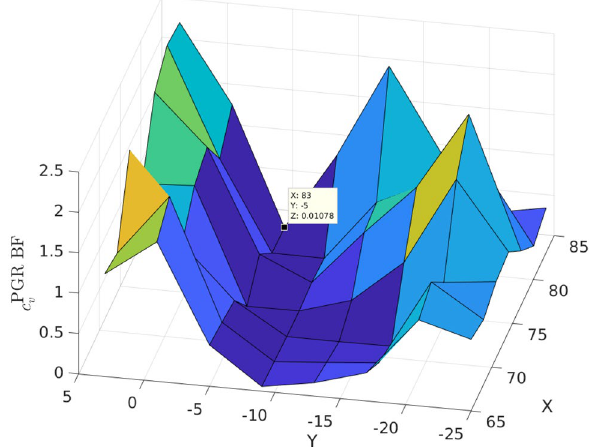
Fig. 21 c PGR v index for each (X,Y) sphere’s position, considering full pose variations, 𝐩 i ∈ ℝ